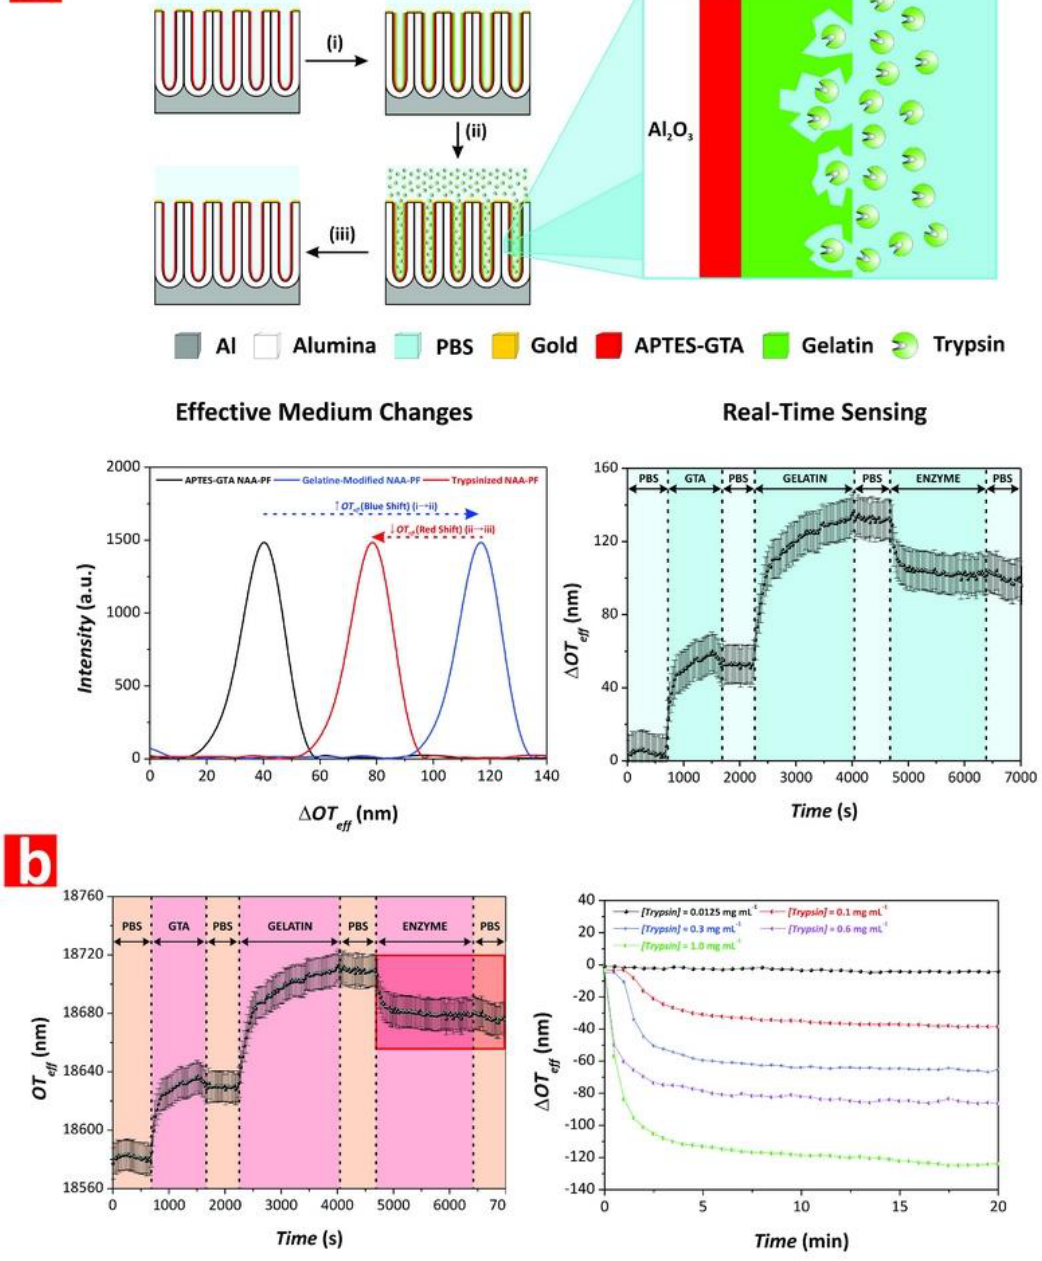
Figure 12. Examples of applicability of NAA-PCs in chemo- and biosensing applications. ( a ) Sensing concept, surface chemistry, and sensing principle for enzymatic sensor combining gelatin-